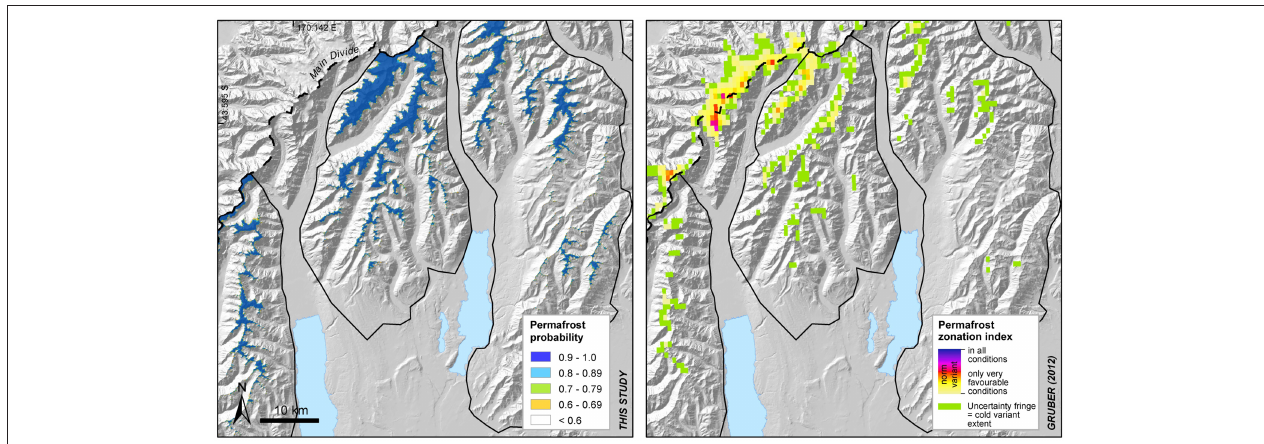
FIGURE 10 | Comparison of this study’s model results and Gruber’s (2012) global permafrost zonation index for the Liebig Range and Two Thumb Range, central Southern Alps. The results indicate that Gruber’s cold variant assumption may be more appropriate for the application of Gruber’s (2012) model in New Zealand than its normal assumption. Background: hillshade of 15m DEM, Columbus et al.